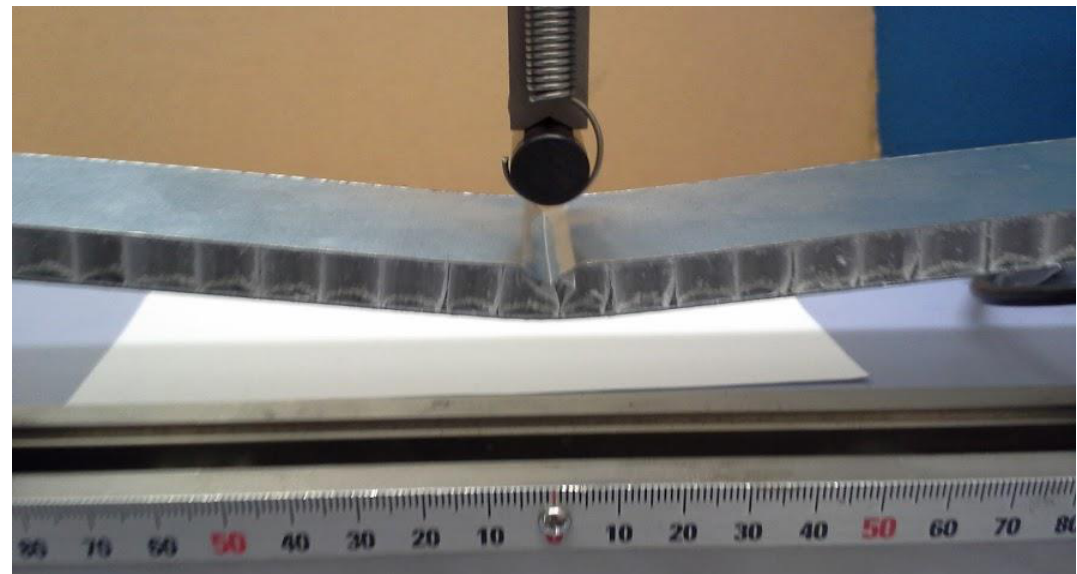
Figure 9. Bending test of sample c2 and failure detail.